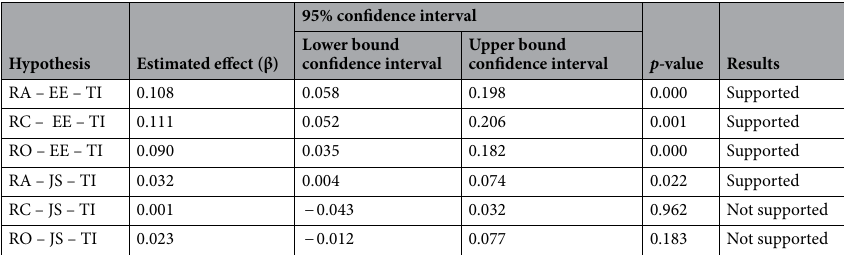
Table 5. Results of bootstrapping analysis. n = 360. RA Role ambiguity, RC Role conflict, RO Role overload, EE Emotional exhaustion, JS Job satisfaction, TI Turnover